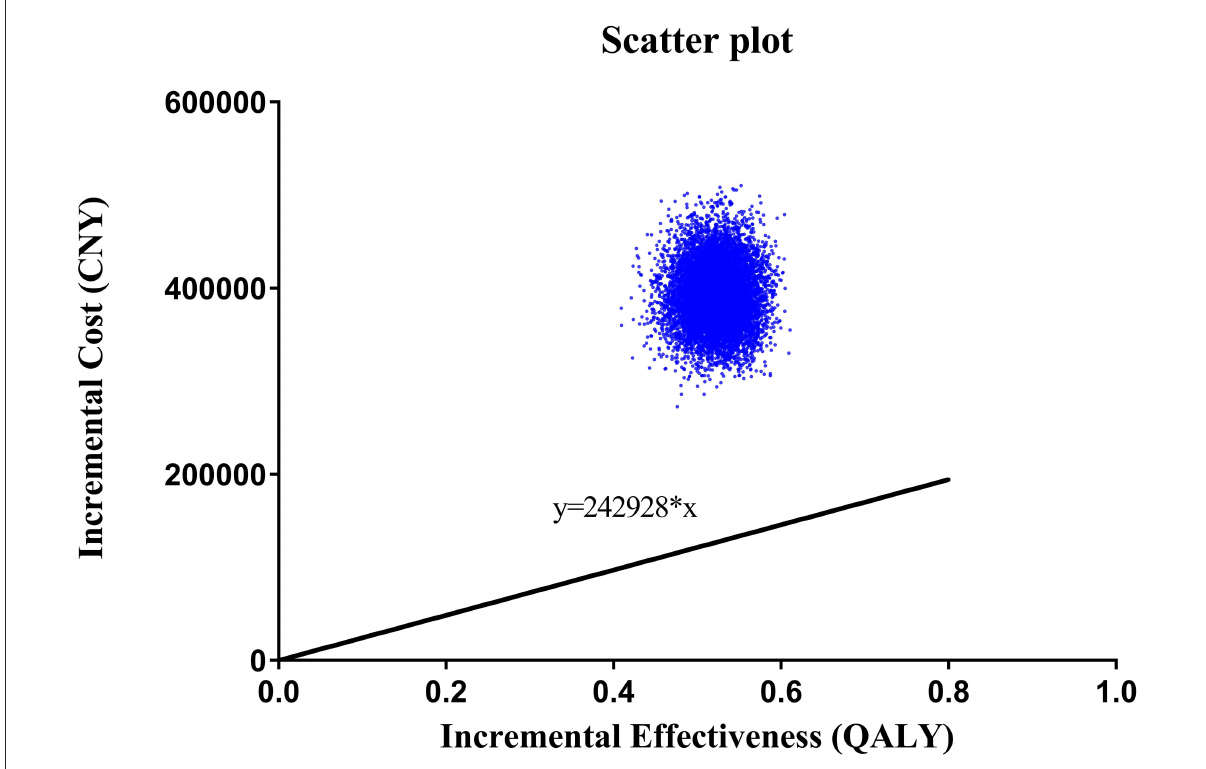
FIGURE3 Scatter plot based on 10,000 times Monte Carlo simulation. The straight line indicated the WTP threshold. The dots were almost all above the line.